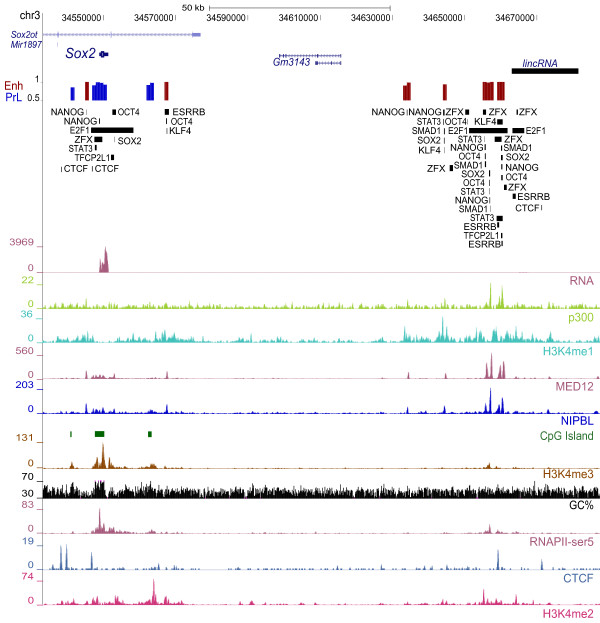
Novel putative enhancer regions aroundSox2. Plot showing novel putative enhancers around the Sox2 gene. The Enh and PrL probabilities of 1 kb bins are shown in red and blue bars, respectively. Only bins with probabilities greater than 0.8 are displayed for higher stringency, and the y-axis scale is from 0.5 to 1. A lincRNA approximately 100 kb downstream of Sox2 near the distal enhancer cluster is shown in black. Transcription factors peaks identified using the SISSRs algorithm are illustrated in rectangle boxes to demonstrate overlaps of the enhancers with TFs. Coverage plots of RNA-Seq data in ES cells and used features are shown at the bottom.